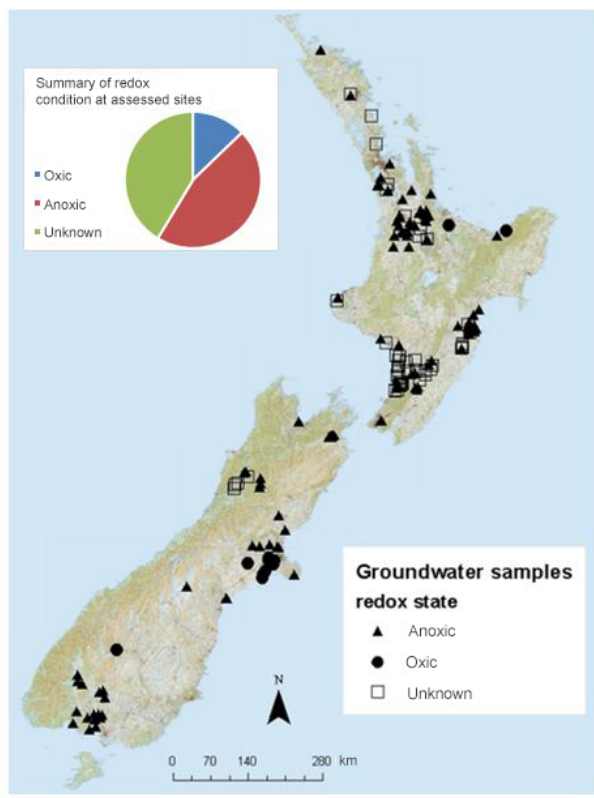
Figure 1. Location of groundwater samples analysed for Halon- 1301 in New Zealand. Groundwater was considered as oxic if the concentration of dissolved oxygen exceeded 0.5mgL − 1 and/or the concentration of dissolved iron and/or manganese was below 0.05mgL − 1 and methane was not present (and vice versa for anoxic water).